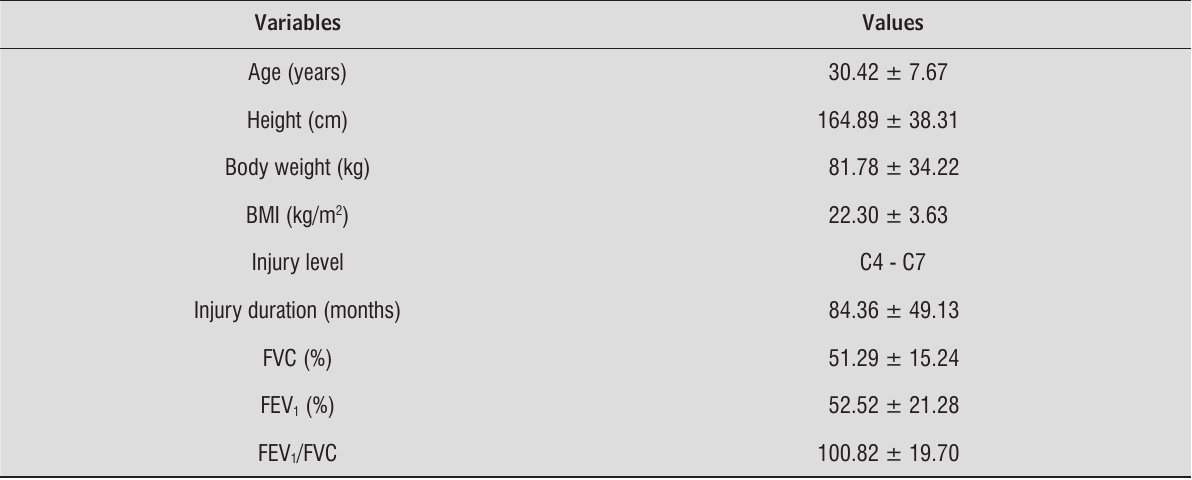
Table 1 - Characteristics of the volunteers studied (n =